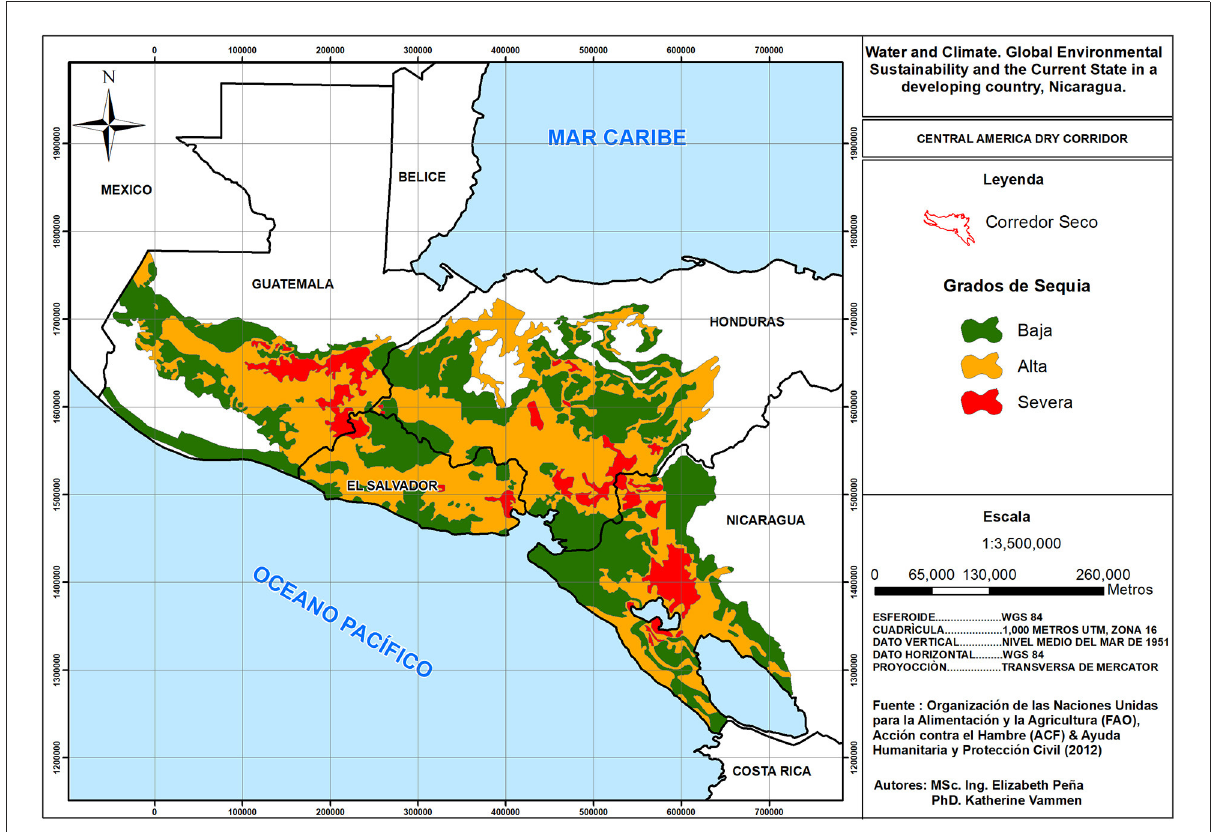
FIGURE5 Dry Corridor of central America and degree of drought (Prepared by the authors on the basis of data supplied by Food Agriculture organization of the United Nations-FAO, 2012).